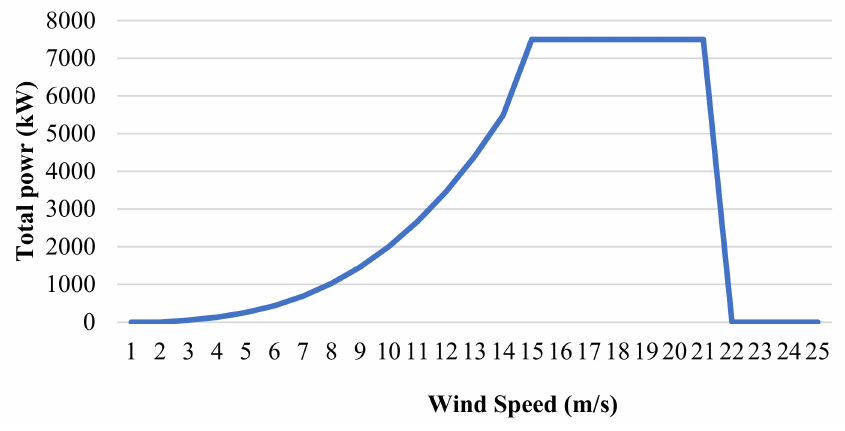
Figure 13. Total power for different wind